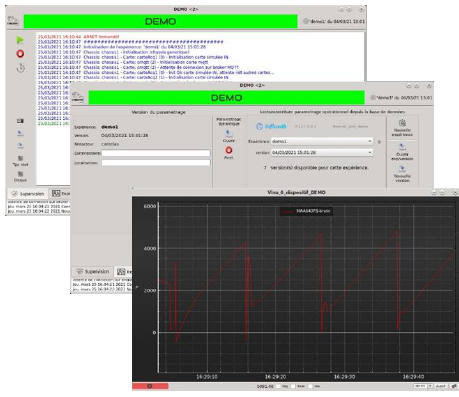
Fig. 10. CAREDAS configuration tool.